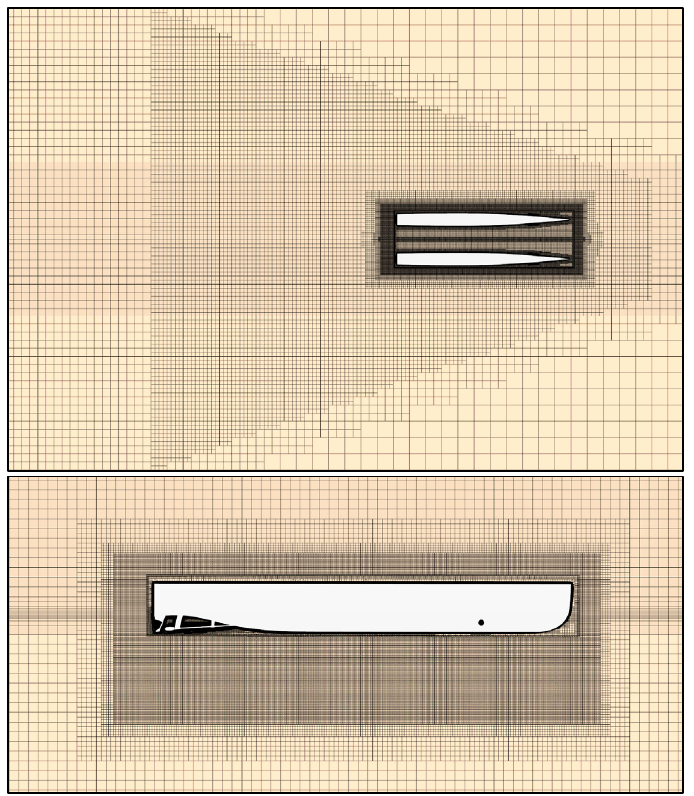
Figure 4. Grid structure on the free water surface ( upper ) and the symmetry plane of a demi-hull ( lower ) in the CFD simulations of the catamaran.